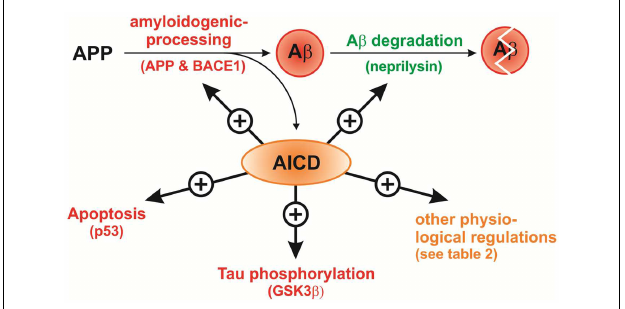
FIGURE 5 | Regulation of genes involved in neuroprotection (green), neurotoxicity (red) or other genes (orange) byAICD . On the one hand AICD enhances ( + ) the expression and/or activity of APP, the β -secretase BACE1, p53, and GSK3 β leading to enhanced A β generation, apoptosis, and tau phosphorylation. On the other hand AICD also induces NEP gene expression resulting in increased A β degradation and reduced A β levels. A regulatory cycle can be postulated, in which AICD regulates its own production via induction of APP and BACE1 gene expression also generating A β peptide, whose degradation is stimulated at the same time via upregulation of NEP expression.